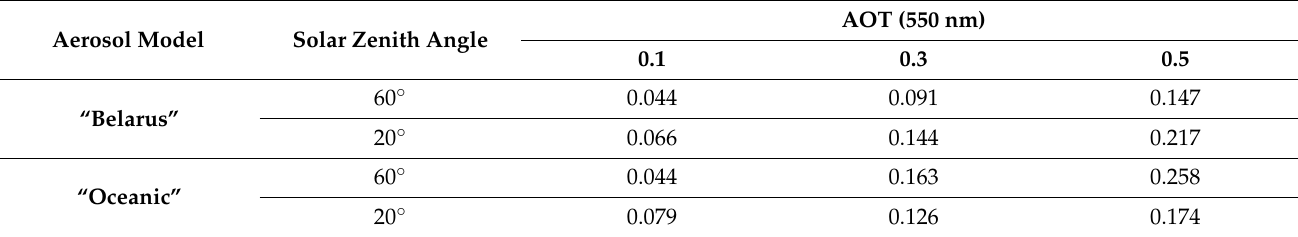
Table 10. RMSE of AOT retrieval with various models of underlying dark surfaces in cases with aerosol models “Belarus” and “Oceanic” considered as true «real» atmospheric aerosols.